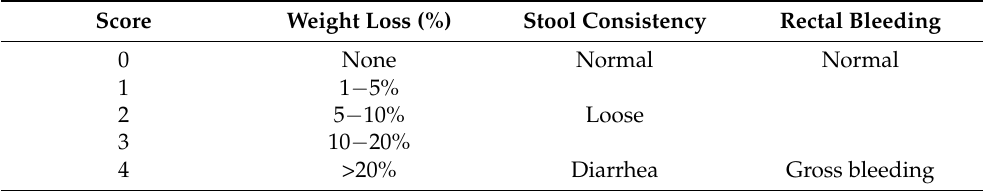
Table 1. DAI scoring system for mice with DSS-induced